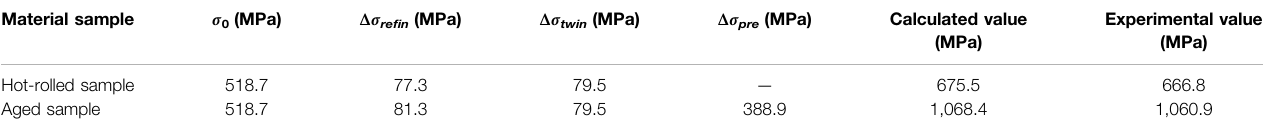
TABLE 2 | The contributions of grain re fi ning, strain-induced twinning, and nanometer precipitate strengthening, and the calculated and experimental values of the yield stress. Material